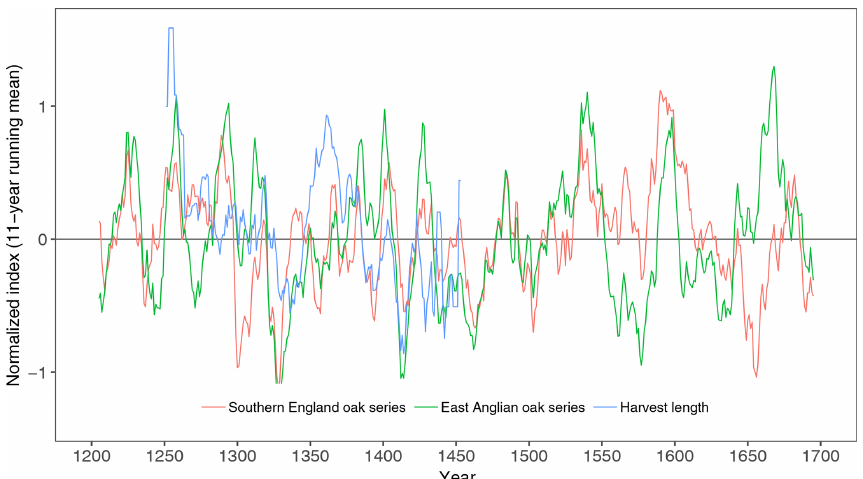
Figure 2. Time series of the tree-ring-based precipitation reconstructions by Wilson et al. (2013) for south-east England and by Cooper et al. (2012) for East Anglia, alongside the precipitation index for East Anglia by Pribyl (2017). Series are normalized over the period 1200 to